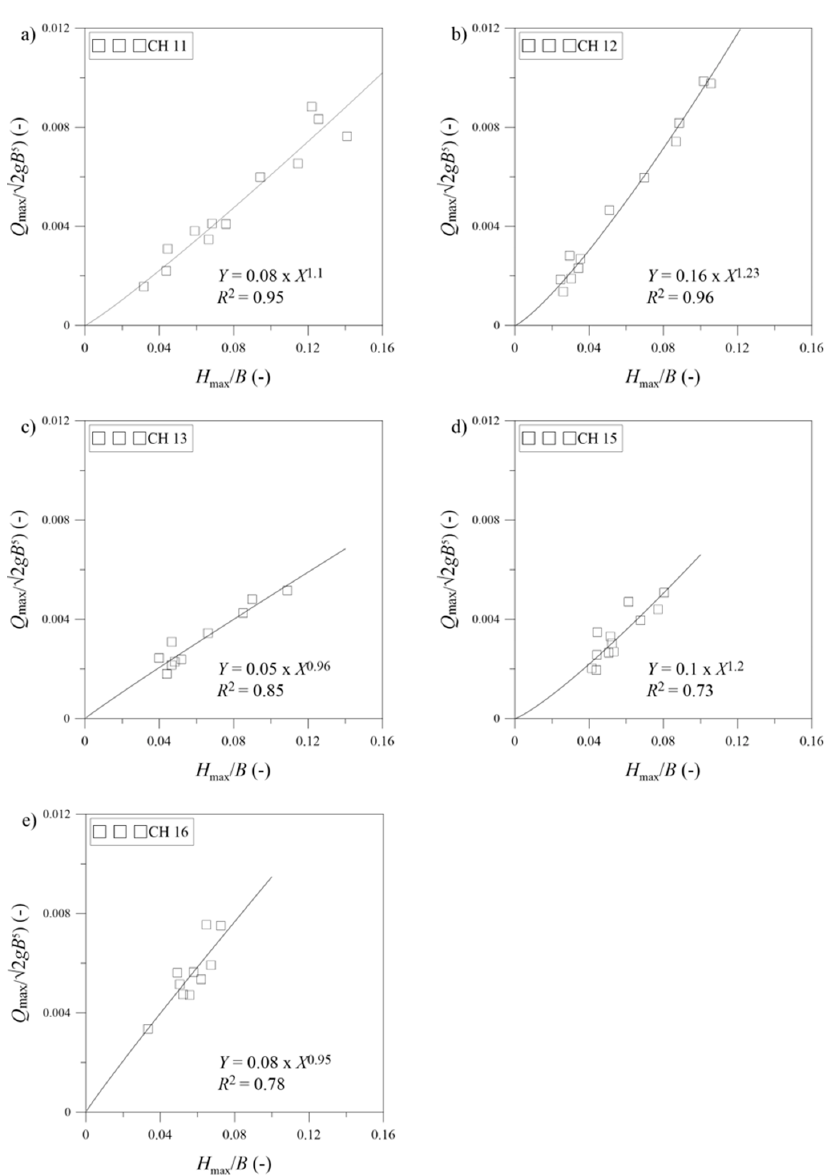
Figure 8. Plot between dimensionless measured maximum overtopping depth and calculated maximum discharge for channel 11, 12, 13, 15, and 16 for an upstream dam slope of 1 to 2.25 for C d calibration.